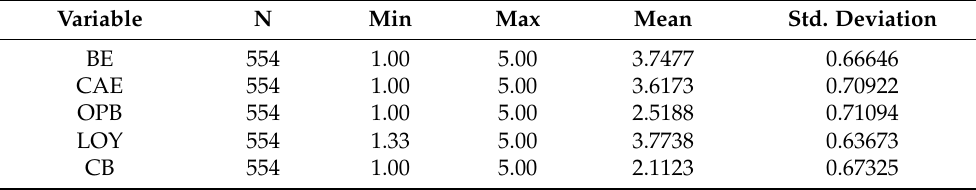
Table 5. Statistical analysis results describing the value of